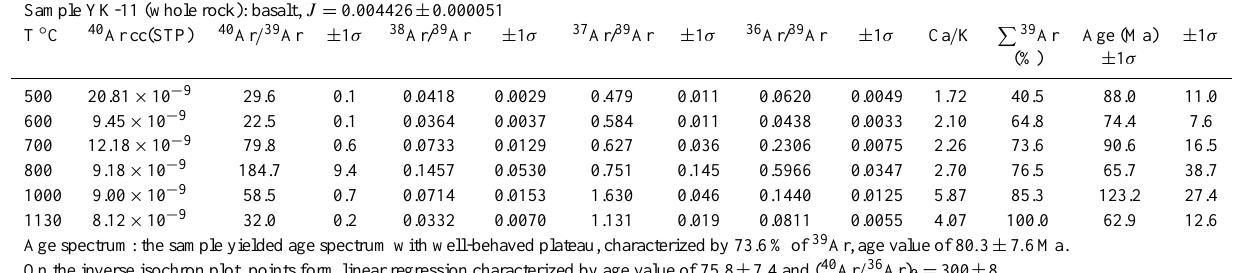
Age spectrum: the sample yielded age spectrum with well-behaved plateau, characterized by 73.6% of 39 Ar, age value of 80 . 3 ± 7 . 6Ma. On the inverse isochron plot, points form linear regression characterized by age value of 75 . 8 ± 7 . 4 and ( 40 Ar / 36 Ar) 0 = 300 ± 8.